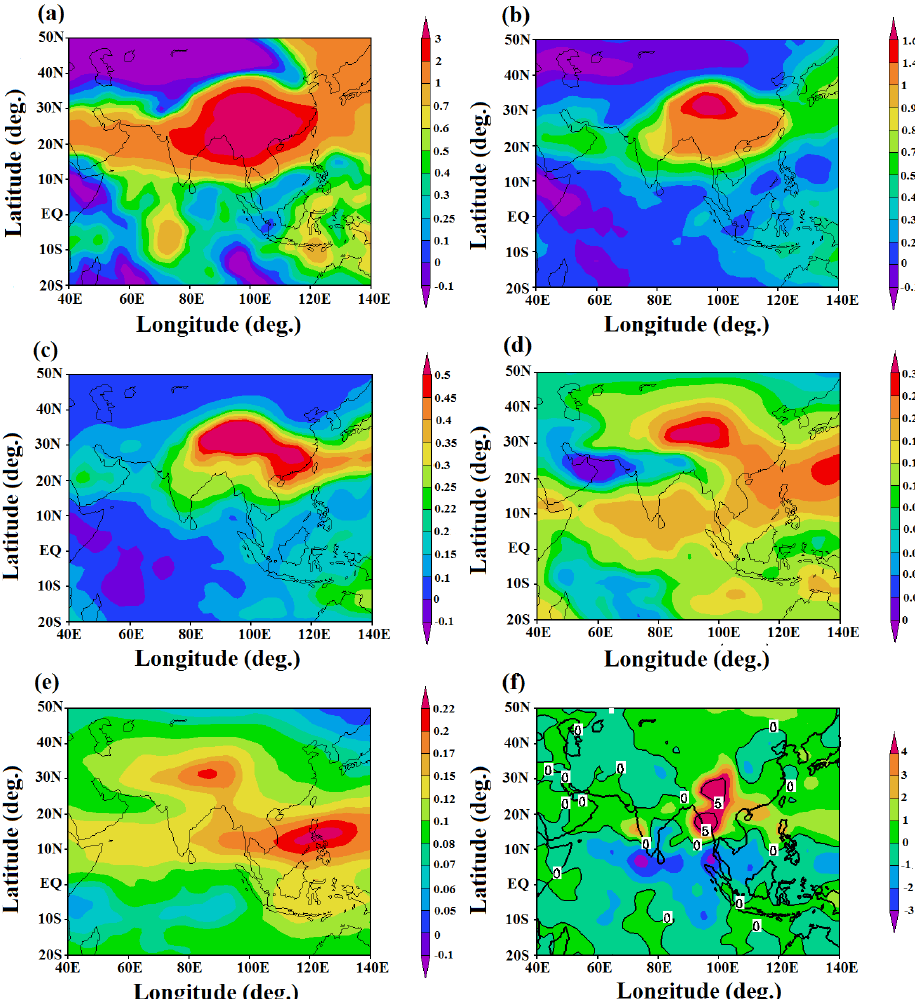
Fig. 11. (a) Spatial structure of mean water vapour (ppmv) anomalies obtained from ECHAM5-HAMMOZ CTRL–NOAER runs during ASM at (a) 155hPa, (b) 132hPa, (c) 110hPa, (d) 90hPa, and (e) 70hPa, and (f) spatial distribution of mean (JJAS) precipitation (mmday − 1 )